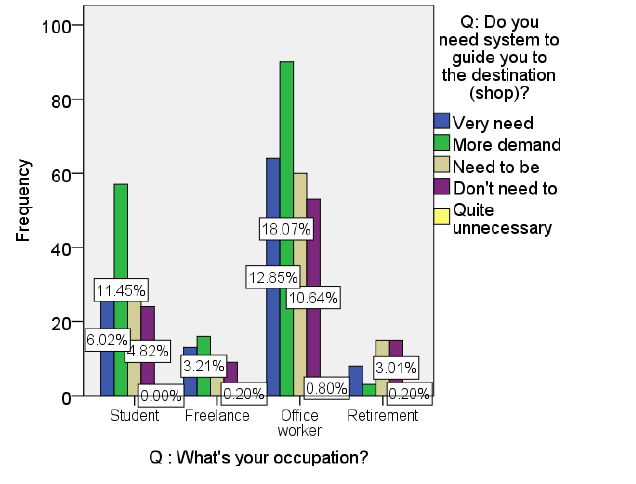
( b ) Figure 15. Frequency comparison between “Age” and personal data related to shopping behavior. ( a ) Do you need a software system to guide you to the des-tination store; ( b ) Are you satisfied with the current signage/system for indoor navigation. Figure 16 shows the basic information of “professional” respondents and the fre- quency of personal data related to shopping behavior contrast, according to the Pearson correlation coefficient and the significant sig value of “professional” and “whether need navigation software/system”. Except for the retired group, the respondents of other occu-